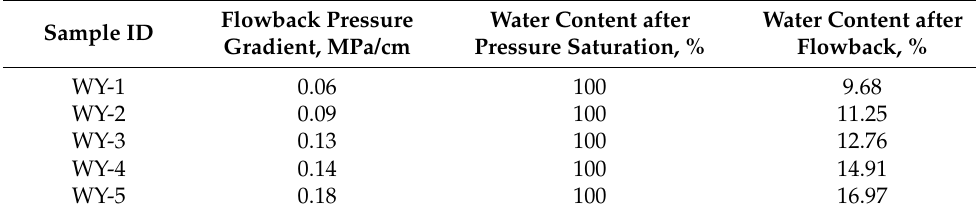
Table 4. Water content in shale pore space after flowback.